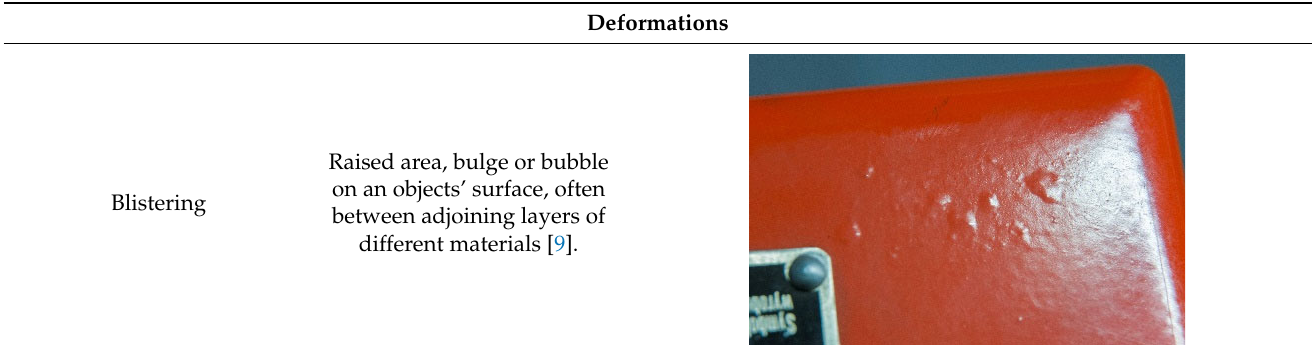
Table 4. Definitions of the category ‘deformations’.